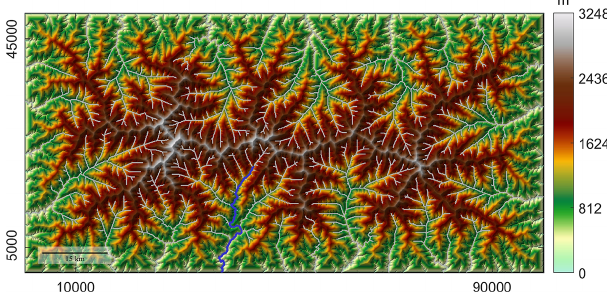
Figure 2. A synthetic steady-state landscape produced as the testing environment to verify and compare the different numerical schemes implemented in TTLEM. Model runtime was 150My, while uplift rate was assumed to be spatially uniform over the area (block uplift) and fixed to 1kmMy − 1 . Other model parameter values are listed in Table 1. Dynamic landscape evolution is presented in Movie S1. The gray lines indicate the drainage network for which the solution has been calculated analytically as a benchmark solution. The blue line indicates the river profile for which model results at different resolutions are plotted in Fig.